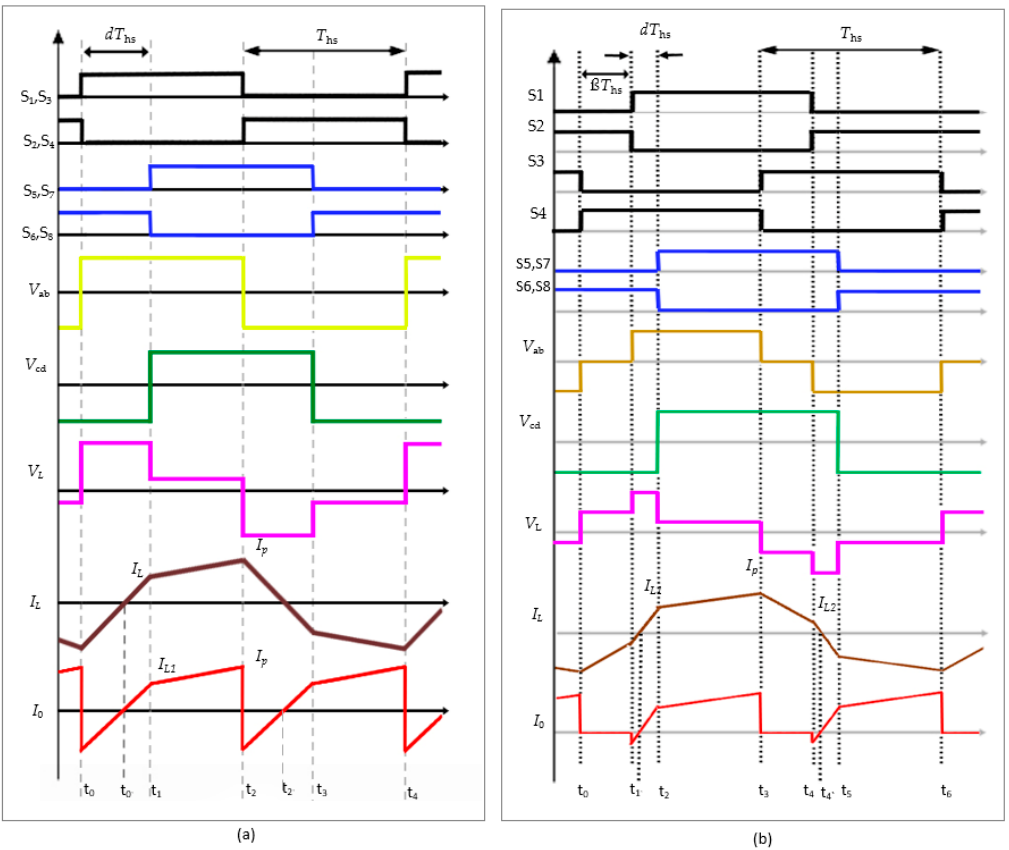
Figure 4. Key operating waveforms of DAB-IBDC during forward (buck) mode. ( a ) Traditional single-phase shift control (SPS), ( b ) extended phase shift control (ESPS).